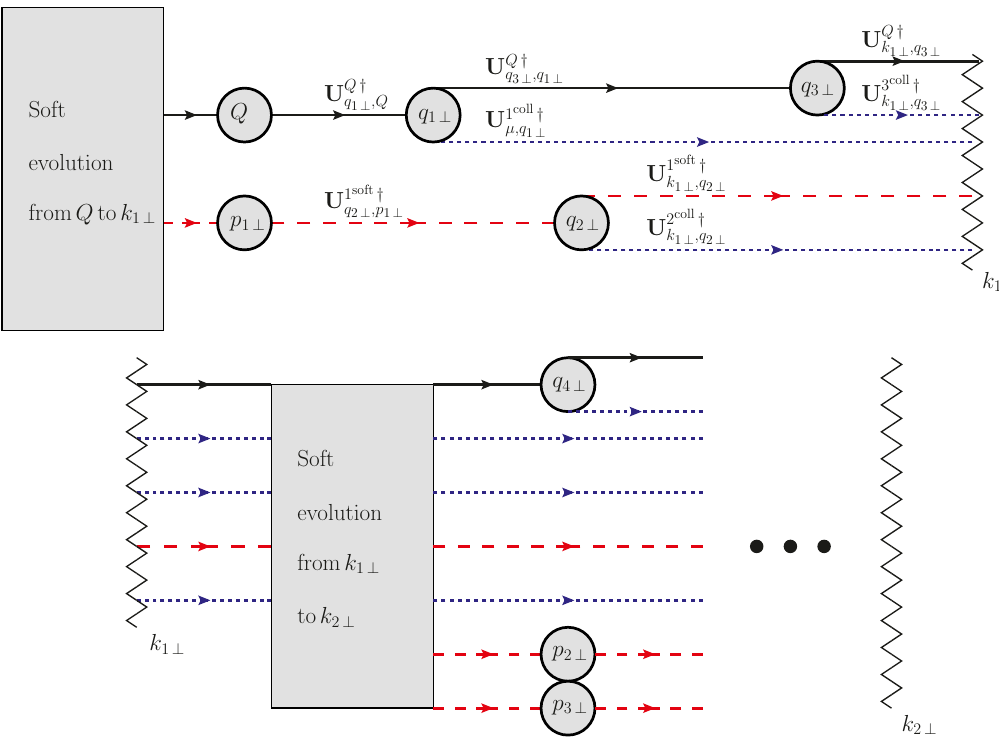
Figure 7. A diagram illustrating factorised parton evolution including Coulomb exchanges. Red dashed lines represent soft gluons and blue dotted lines represent collinear partons. Each line is as- sociated with a Sudakov factor. Circles represent the scale from which the subsequent evolution pro- ceeds. Circles from which two lines leave represent the action of the operator ~ C . Circles from which one line leaves contain the scale information from the preceeding soft evolution. Coulomb exchanges are indicated by vertical zig-zag lines. Momenta are ordered from ‘left to right’, as in (cid:12)gure 5, in- cluding Coulomb exchanges. (The top half of the diagram lies to the ‘left’ of the bottom half.) on a hard process up to the scale of the (cid:12)rst i(cid:25) term ( k 1 ? ). We can take the output